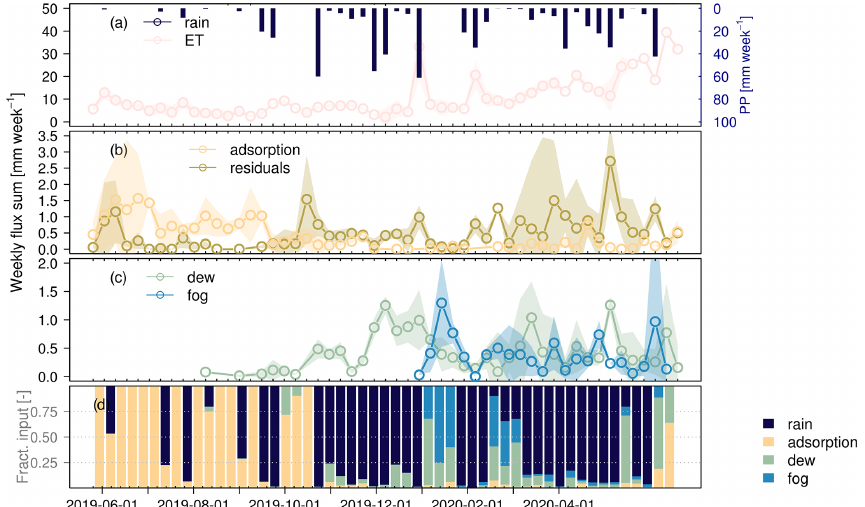
Figure 3. Median of weekly flux sums across lysimeters for (a) ET and rain, (b) adsorption and noise, and (c) dew and fog. (d) Relative contributions of rain and NRW inputs to total water input per week, respectively. Shading indicates the variability across lysimeter columns expressed as an interquartile range (IQR).